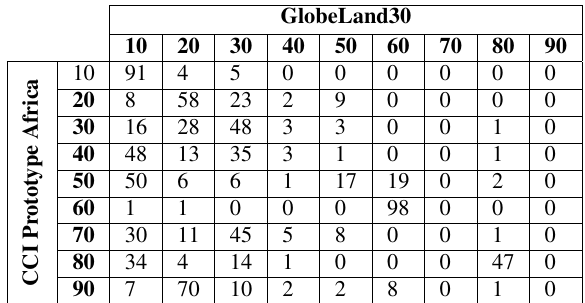
Table 4. Column-wise normalized confusion matrix [%]. Numbers in bold represent codes of classes, described in Table 1. Table 5 is confusion matrix normalized by rows (i.e. divided by the total number of pixels in a CCI Africa Prototype class). Di- agonal elements are analogous to what is usually called User’s accuracy, when the rows are representing classified map in accuracy assessment (Congalton, 2004). Here, diagonal ele- ments are showing percent of agreement between GL30 and CCI Africa Prototype in each class, measured with respect to total number of pixels per each class of CCI Africa Prototype. The table reports high agreement for classes Cropland (10) and Water (60) which is consistent with the previous table. Confu- sion, on the opposite, is evident for Shrubland (40) and Wetland (50) classes of CCI Africa Prototype with class Cropland (10) of GL30.